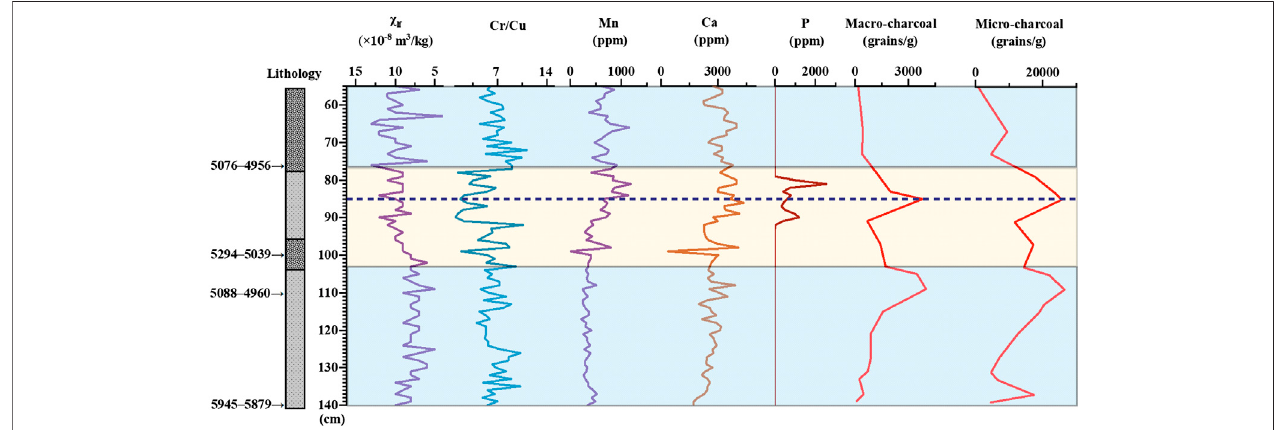
FIGURE 4 | The low-frequency magnetic susceptibility ( χ lf ), XRF scanning results (Cr/Cu, Mn, Ca, and P), concentrations of macro-charcoal and micro-charcoal in pro fi le T0103 of the Hejia